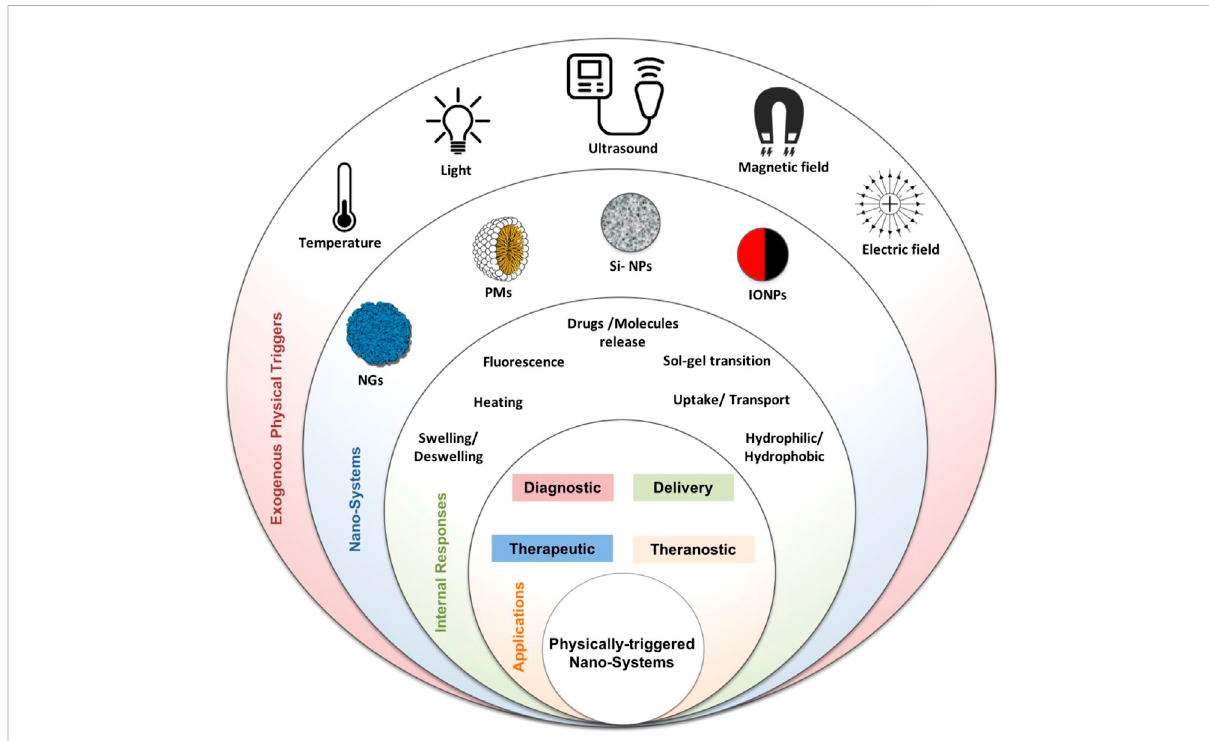
FIGURE 1 Physically triggered nano-systems (PTNSs) schematic image: exogenous physical triggers (temperature, light, ultrasound, magnetic,